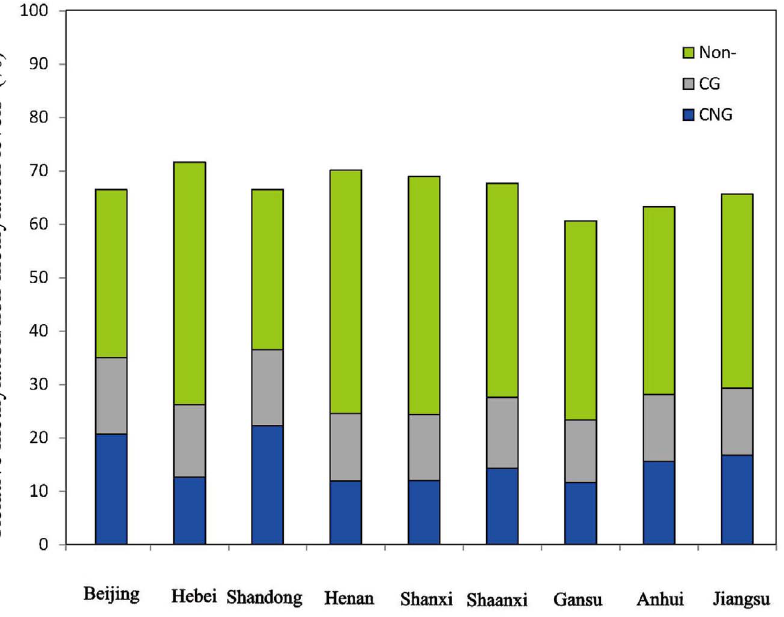
Figure 2. Relative methylation/non-methylation levels in the nine natural populations. CNG, CG, and Non- represented hemi-methylation, full methylation, and non-methylation, respectively. Significant differences between relative CNG and CG methylation levels within each population was examined using a Wilcoxon rank sum test with P -values of P =0.026 (Beijing), P =0.018 (Hebei), P =0.002 (Shandong), P =0.001(Henan), P =0.225 (Shanxi), P =0.086 (Shaanxi), P =0.109 (Gansu), P =0.821 (Anhui), and P =0.602 (Jiangsu), respectively. Also, significant differences between relative total methylation and non-methylation levels within each population was also examined using the Wilcoxon rank sum test with P -values P =0.066 (Beijing), P =0.001 (Hebei), P =0.012 (Shandong), P , 0.001(Henan), P , 0.001 (Shanxi), P , 0.001 (Shaanxi), P =0.055 (Gansu), P =0.064 (Anhui), and P =0.465 (Jiangsu), respectively.